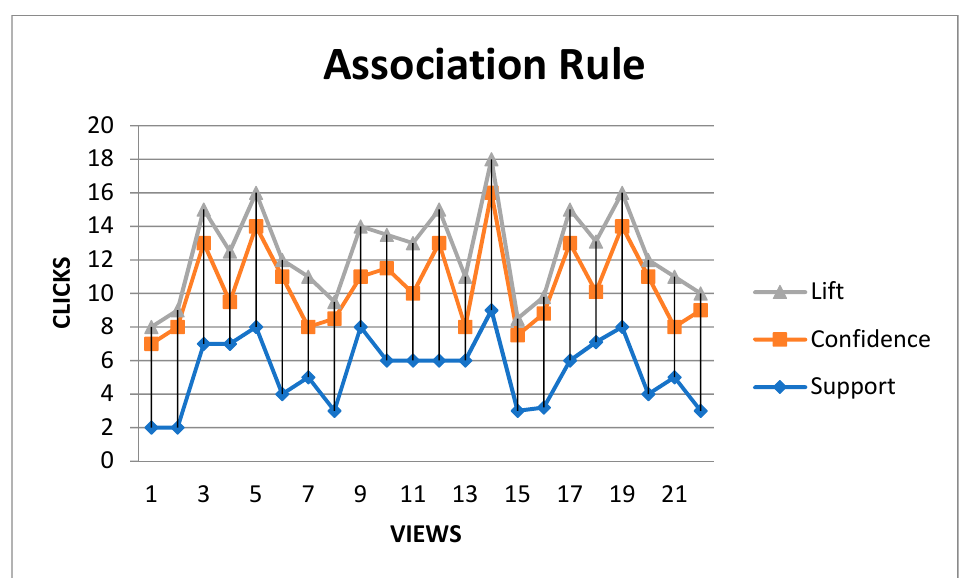
Figure 7. Total association of transaction data.